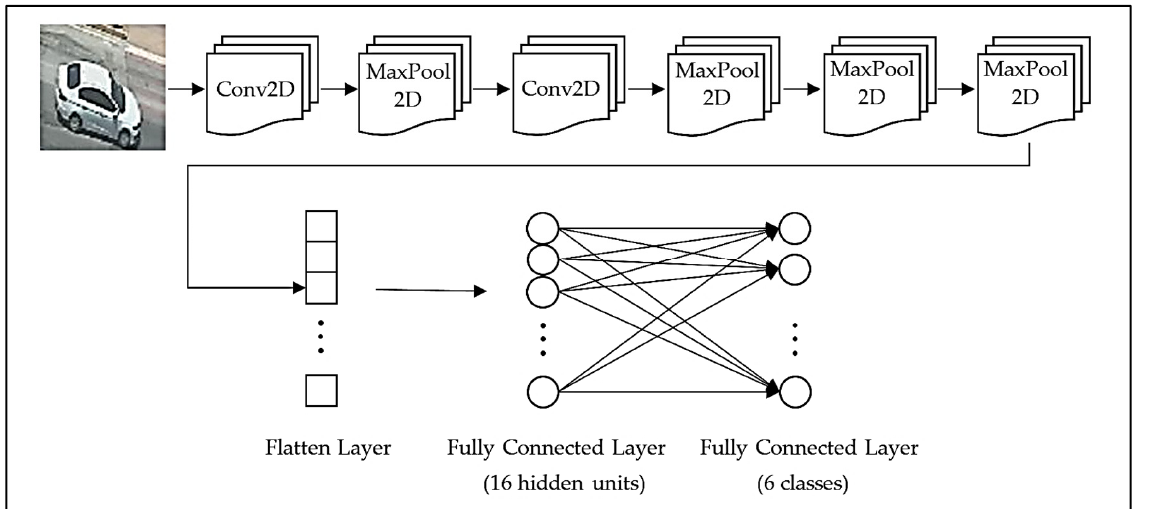
Figure 1. Architecture of the proposed model.